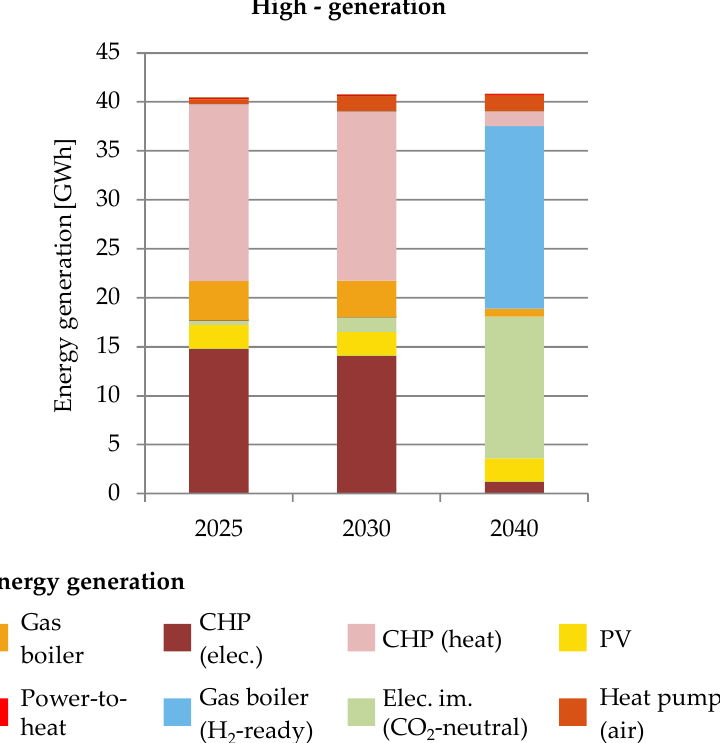
Figure 17. Energy generation for the high scenario (myopic_years, without CCS).